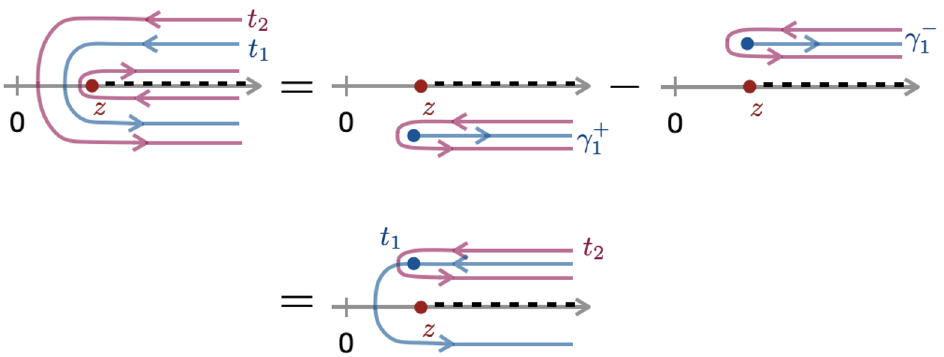
Figure 6 . Contours associated with the adjoint